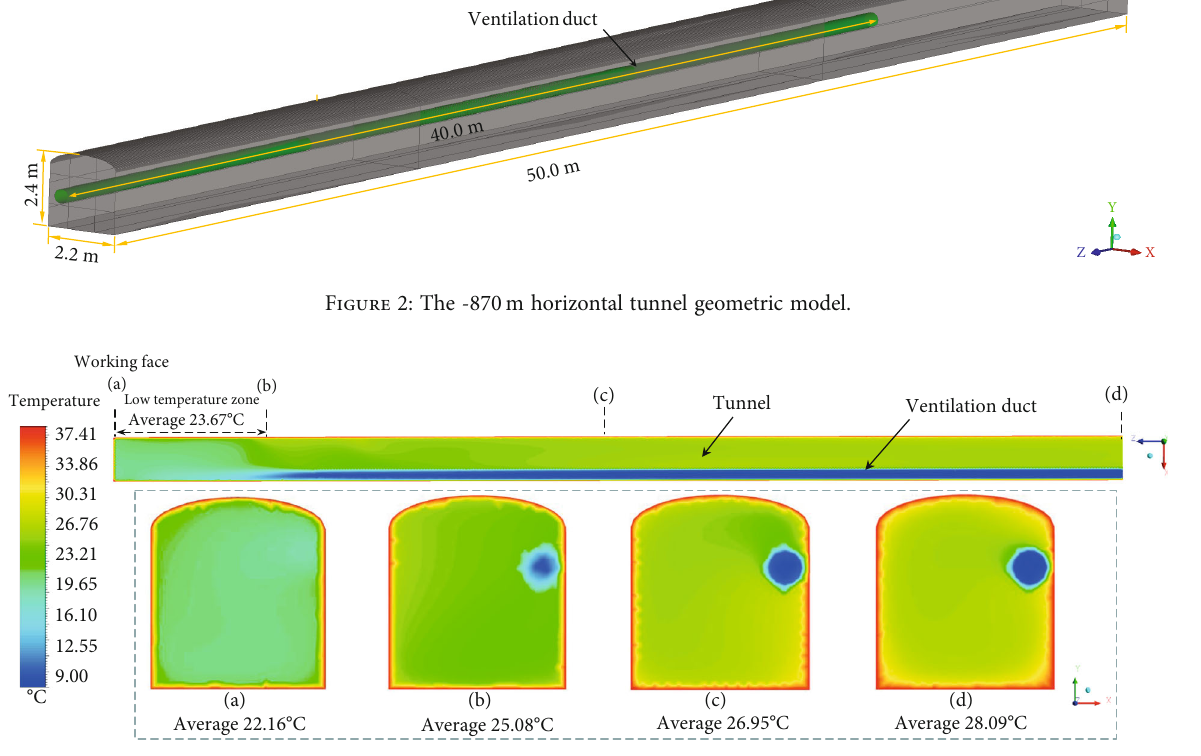
Figure 3: Temperature distribution diagram of tunnel under the condition of air supply temperature of 9 ° C.